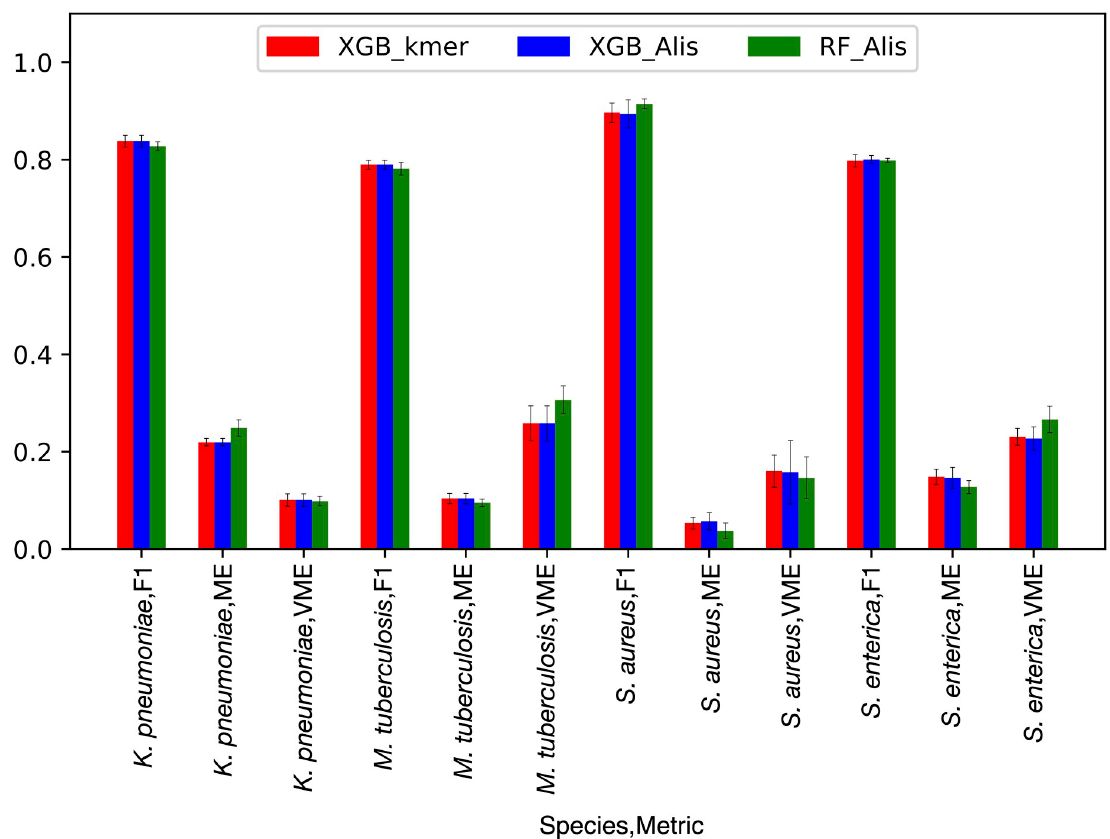
Fig 6. A comparison of algorithms and features. The same set of 100 randomly-selected core genes was used to build each model. Each set of bars represent the F1, ME, and VME scores for K . pnuemoniae , M . tuberculosis , S . enterica , and S . aureus , respectively. The red, blue, and green bars represent the accuracy metrics (F1, ME, or VME) for the XGBoost model built from k-mers for the gene set, XGBoost model built using a concatenated alignment where the columns were one-hot encoded, and random forest model built using a concatenated alignment where columns were one-hot encoded, respectively. Error bars depict the 95% confidence